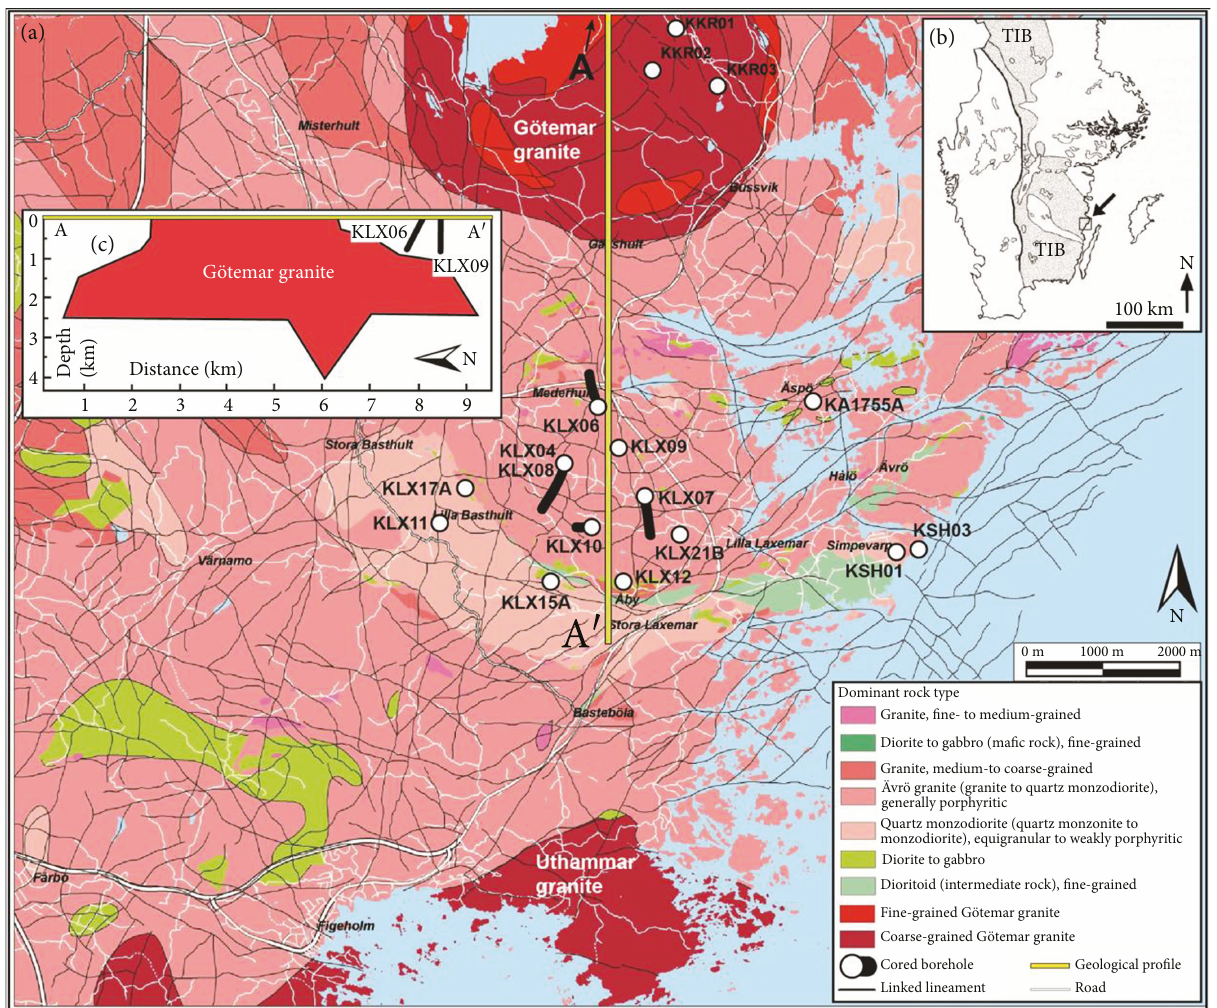
Figure 1: (a) Bedrock map after Wahlgren et al. [32] of the Laxemar area outlining borehole locations and fracture lineaments (also indicated are villages and roads). Thick black lines indicate underground extension of inclined drill cores. KLX04 is vertical while KLX08 stretches to SW. (b) Regional map of south Sweden indicating the location of the Transscandinavian Igneous Belt (TIB) in grey shade and the Laxemar area with arrow. (c) Geological model adapted from Cruden [21] of the Götemar granite across a N-S trending pro fi le stretching beyond the map in a northerly direction, with the relative location of drill cores KLX06 and KLX09 indicated. At least one sample from each drill core outlined in the map has been used in this